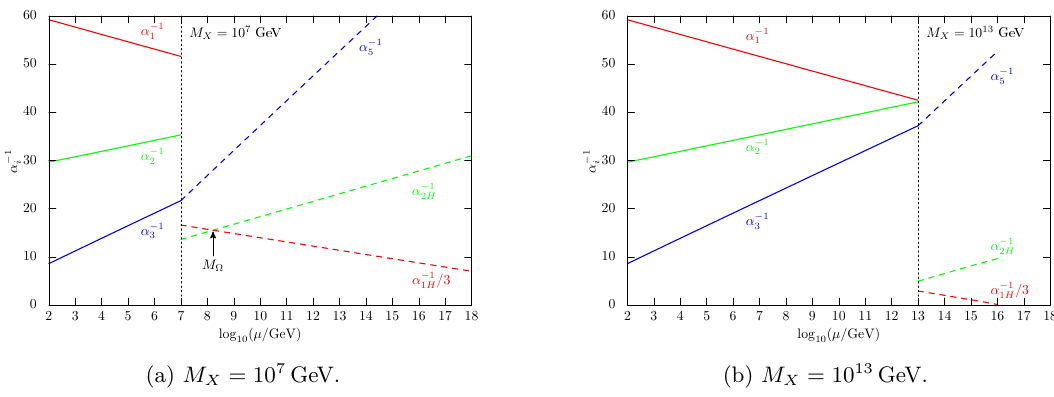
Figure 3. The left (right) figure shows the running of gauge couplings when M X = 10 7 GeV ( M X = 10 13 GeV ). The red, green, and blue solid lines denote the runnings of α − 1 respectively. The red, green, and blue dashed lines are, respectively, the runnings of α − 1 and α − 1 . Here we assume that only the particles contained in the SU(5) × U(2) H model contribute 5 to the running of gauge couplings. The figure shows that the matching between U(2) H and SU(3) H is possible for the left panel while it is not possible in the right